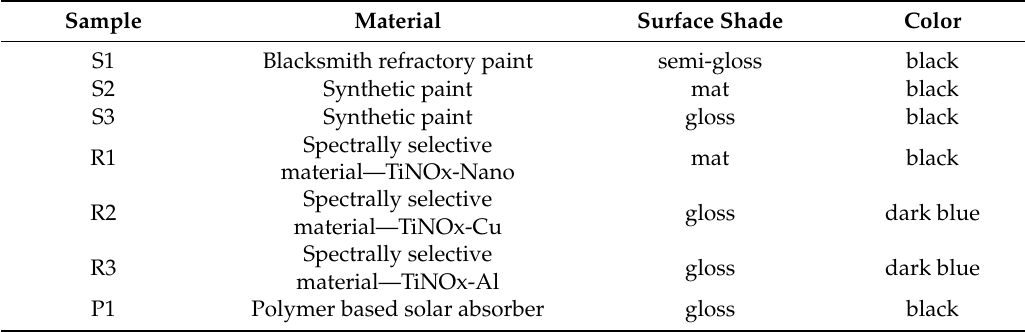
Table 1. Summary of measured solar absorber samples.